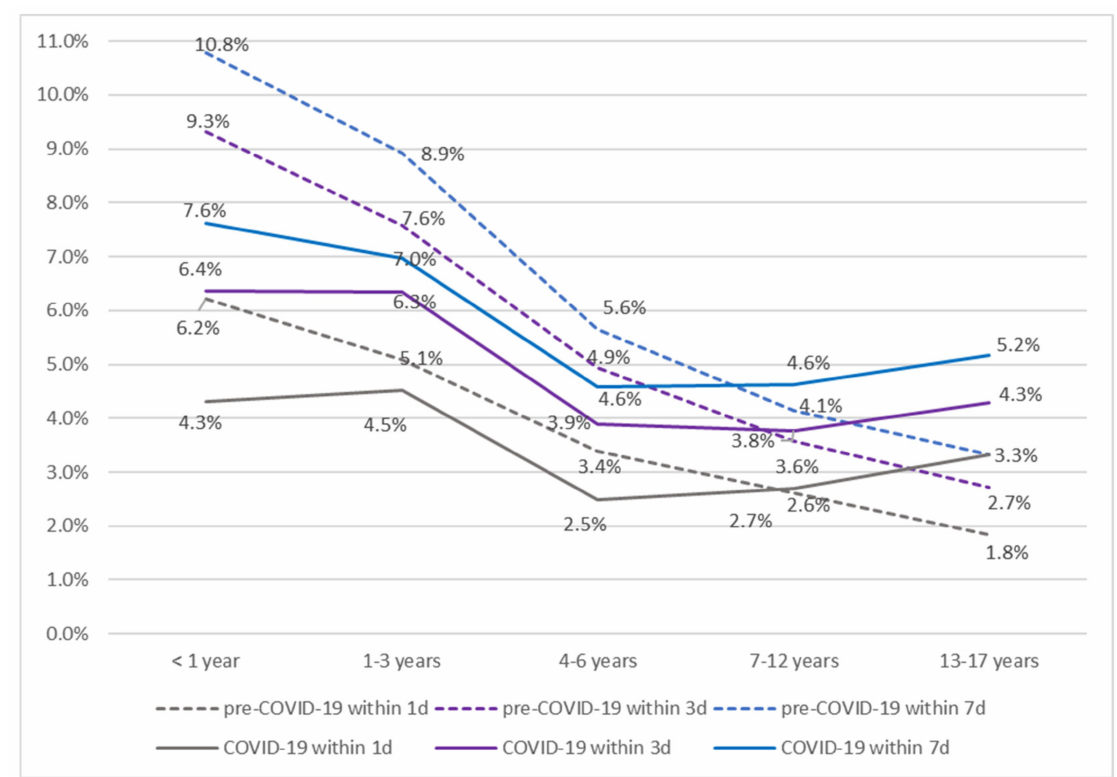
Figure 2. Revisit rates during the pre-COVID-19 and COVID-19 periods based on five age